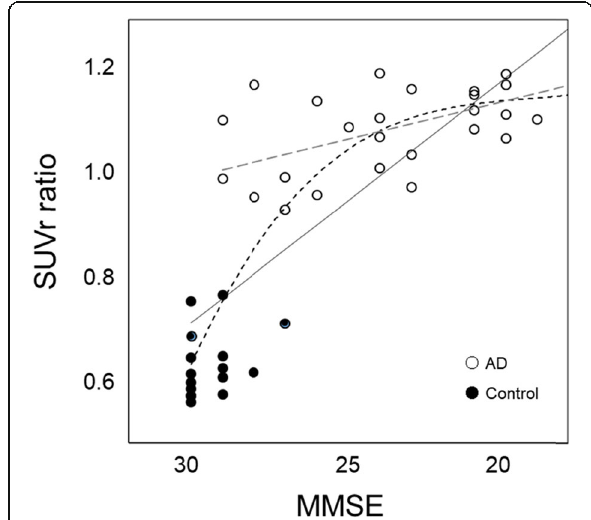
Fig. 6 Scatter plot of SUVr ratio calculated by GM-SUVr/WM-SUVr and MMSE score. AD patients (open circle) showed a significant correlation (gray dotted line, r = 0.59, P < 0.01) and significantly greater ratio than CTL. All plots for both groups also showed a significant correlation (solid line, r = 0.81, P < 0.0001). Black dotted line represents theoretical assumption line from previous